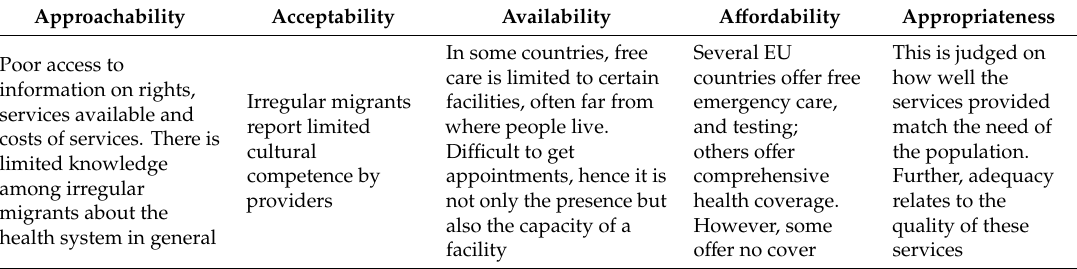
Table 1. The five dimensions of